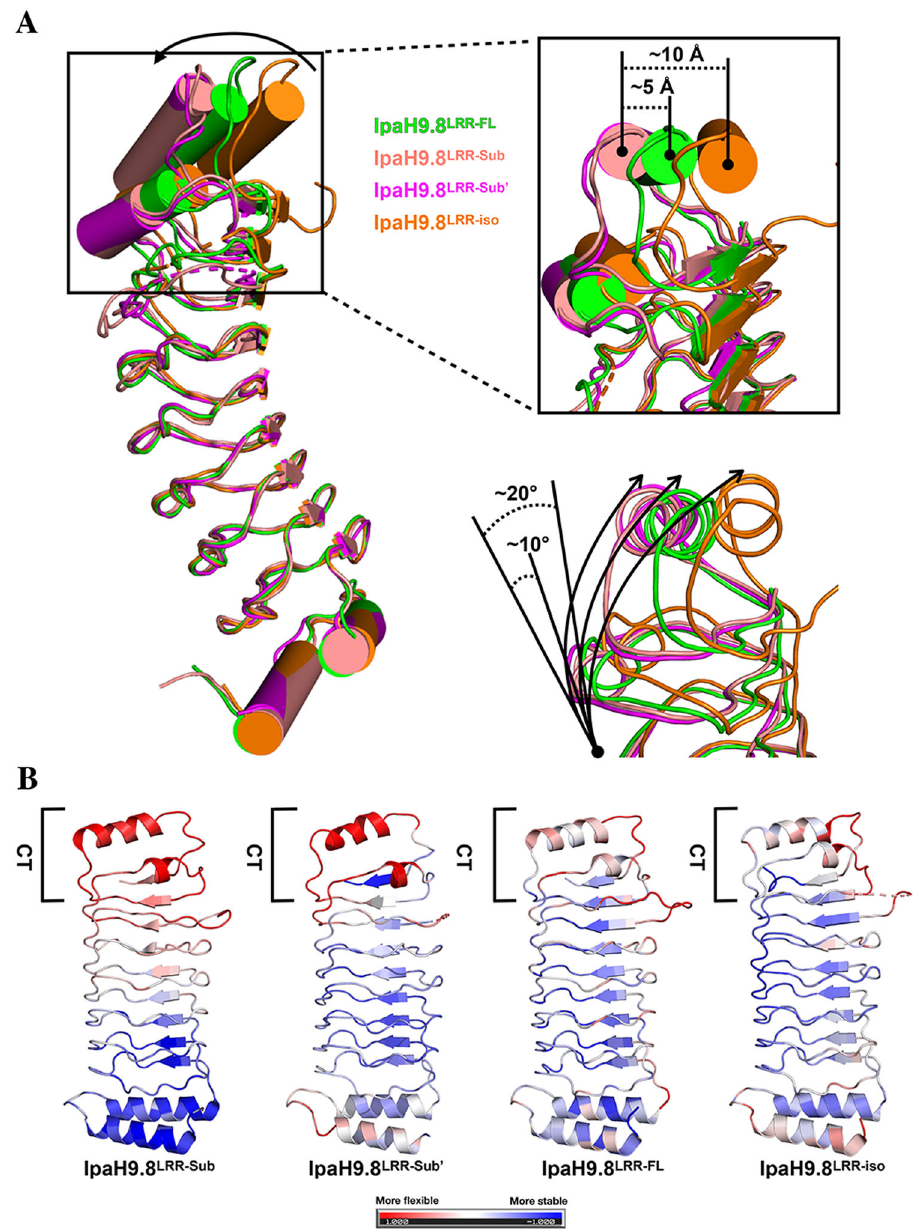
Fig. 4 Substrate-binding destabilized the hydrophobic cluster in LRR-CT. A Left, superimposition of the structures of IpaH9.8 LRR-Sub , IpaH9.8 LRR-Sub ’ (PDBID: 6K2D), IpaH9.8 LRR-FL , and IpaH9.8 LRR-iso (PDBID: 5B0T) by the LRR-NT with the LRR domains differentiated by colors. Arrows indicate the rotation of LRR-CT when bound to hGBP1. Right-top and right-bottom, magni fi ed view of LRR-CTs in different IpaH9.8 LRR constructs as in left. Relative differences in shift distance (top) and rotation angles (bottom) for LRR-CT are indicated. B The cartoon models of IpaH9.8 LRR-Sub , IpaH9.8 LRR-Sub ’ , IpaH9.8 LRR-FL , and IpaH9.8 LRR-iso are colored by normalized B-factor (1 to 0 to − 1; red to white to blue, red indicating fl exibility and white indicating